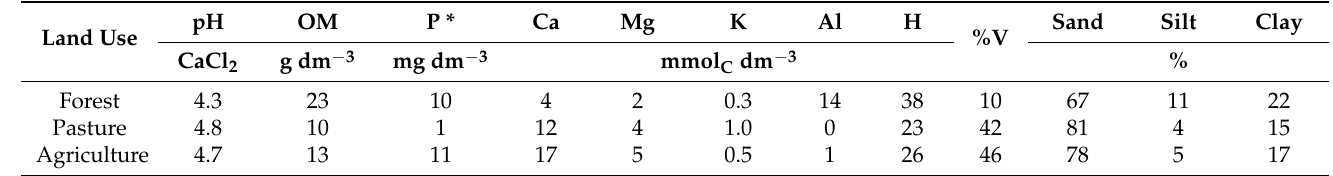
Table 1. Soil physical-chemical characteristics in different land-use